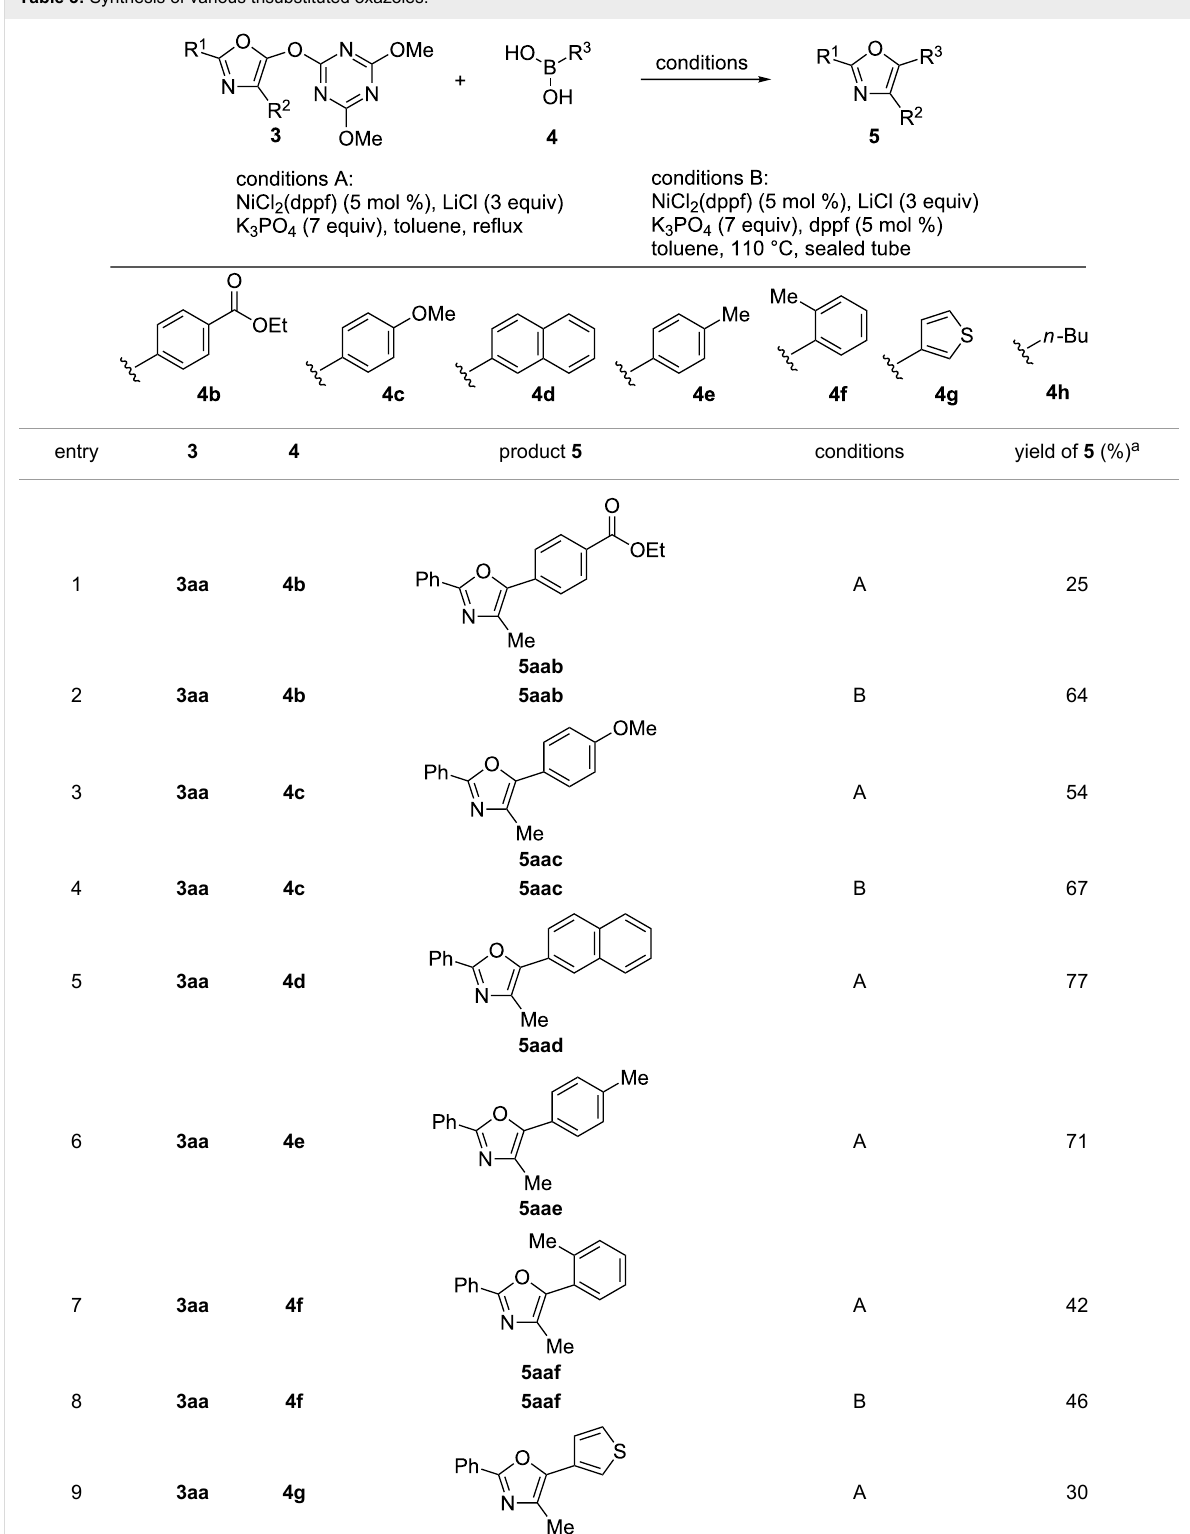
Table 3: Synthesis of various trisubstituted